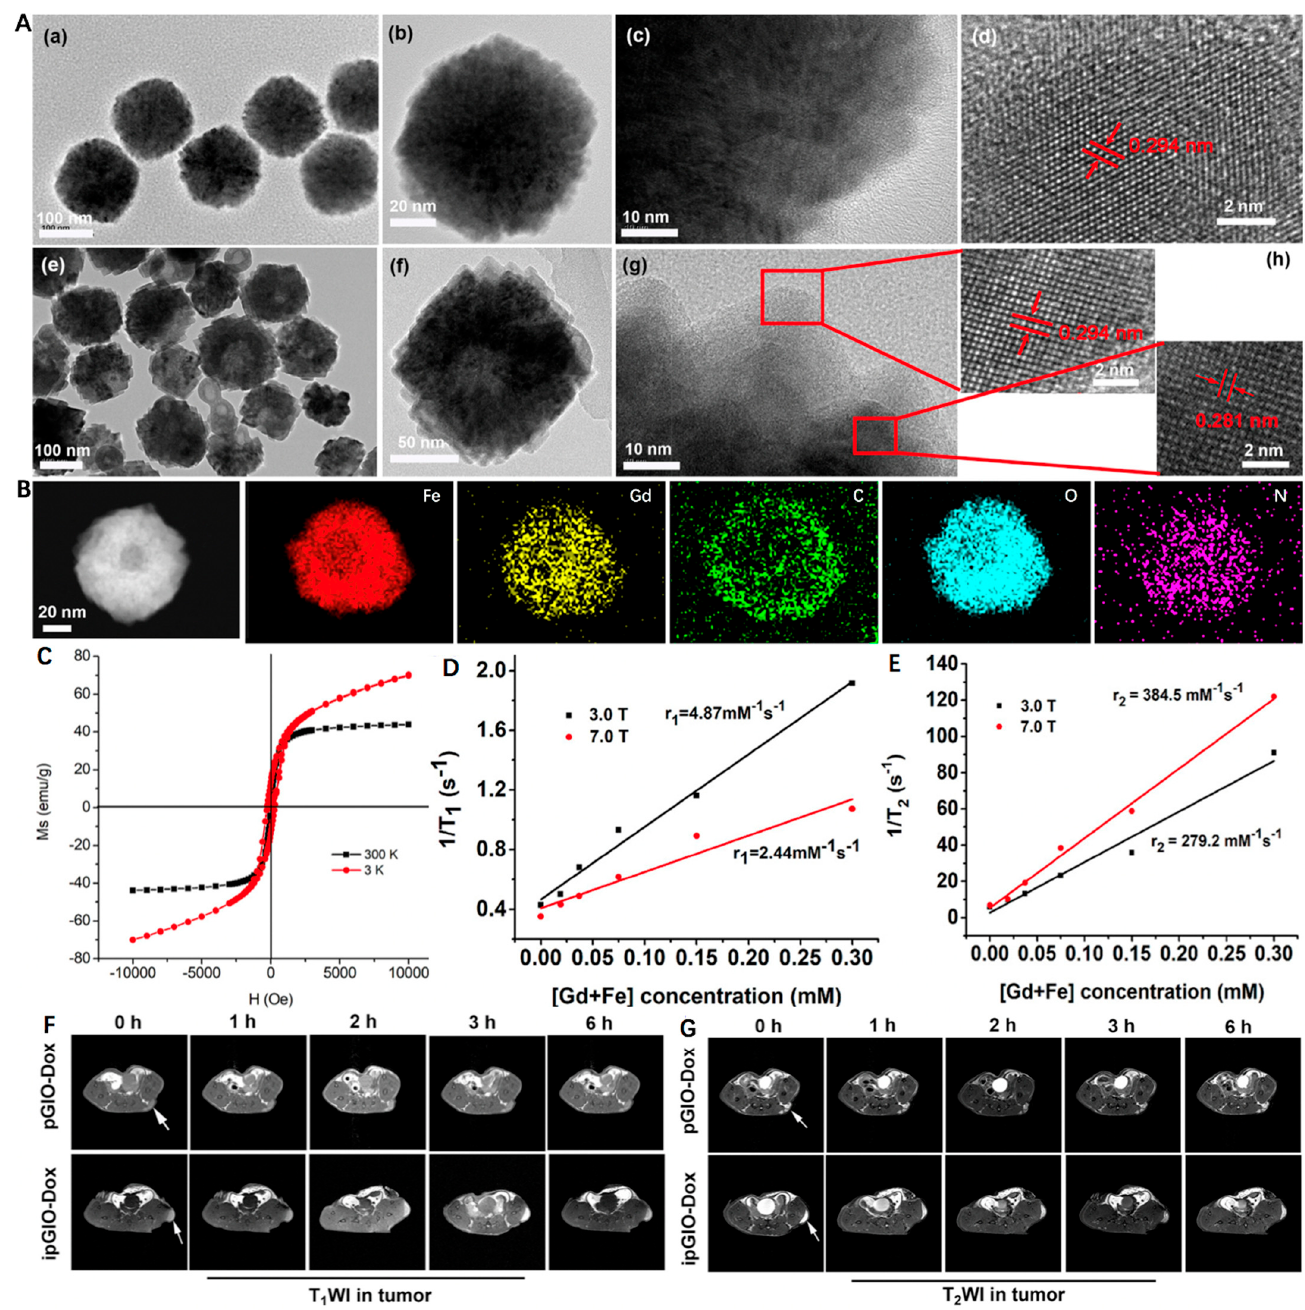
Figure 3. ( A ) TEM images of ( a − c ) MIO and ( e − g ) GdIO. HRTEM images of ( d ) MIO and ( h ) GdIO. ( B ) Energy dispersive spectrometry mapping images of GdIO. ( C ) Field-dependent magnetization curve of GdIO at 3 and 300 K. ( D ) Transverse relaxation rate and ( E ) Longitudinal relaxation rate of ipGdIO-Dox measured using 3.0 T and 7.0 T MRI scanners. ( F , G ) T 1 - and T 2 -weighted MR images of cancer-bearing mice at coronal planes after injection of pGdIO-Dox and ipGdIO-Dox. Reprinted with permission from Ref. [81]. Copyright 2022, American Chemical Society.